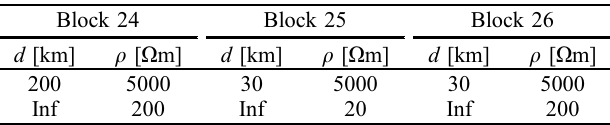
Table 2. Layered models of the ground conductivity applied in Norway. Layer thickness is d and resistivity q (= inverse of conductivity). Block numbering refers to Figure 2. Source of